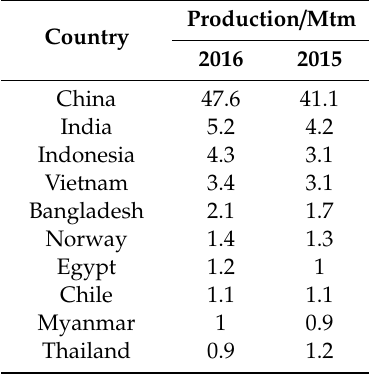
Figure 7. Time evolution of world aquaculture algae production in millions of tons from 1990 to 2016 (source: FAO [31,164–166]). Table 6. Production in aquaculture (Mtm) of main producers in 2015–2016 (Food and Agriculture Organization of the United Nations [31,164]).